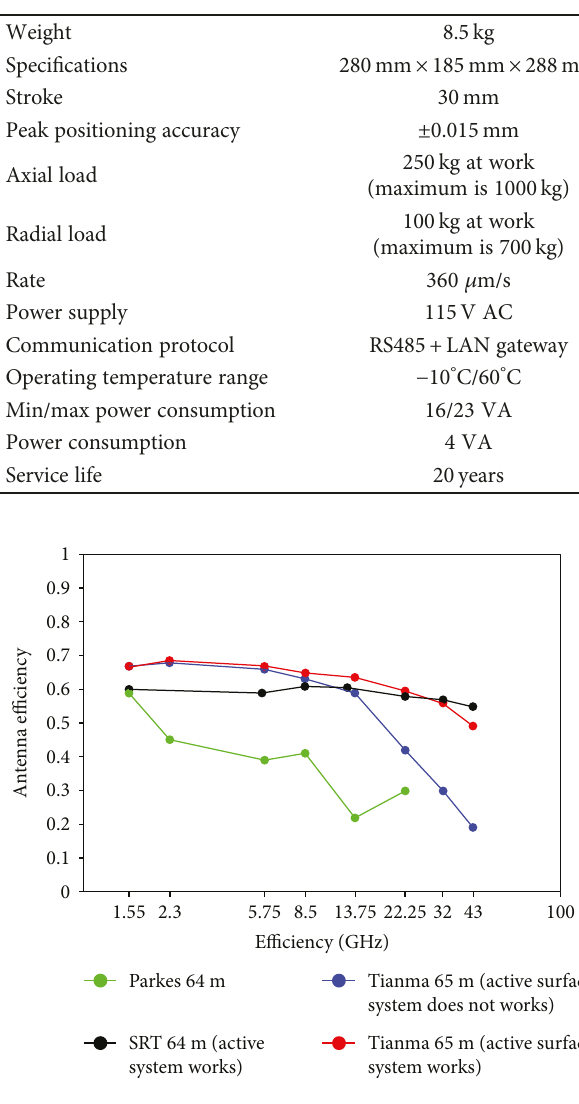
Figure 11: Relationship between working frequency and antenna e ffi ciency of the Tianma telescope